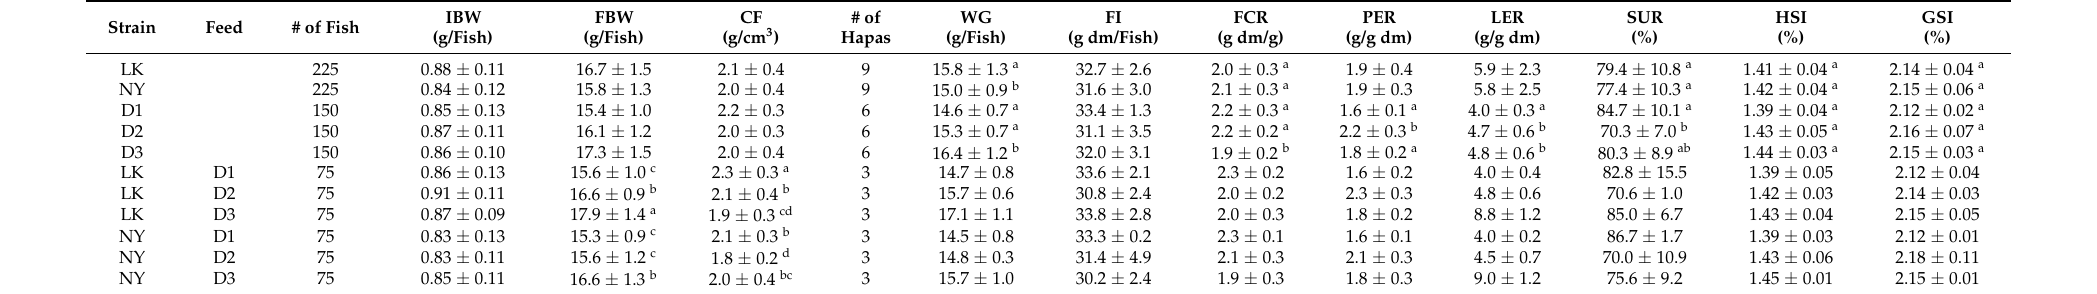
Table 3. Experiment 1 in Bukavu, eastern highlands DR Congo—mean ± standard deviation for initial body weight (IBW), final body weight (FBW), weight gain (WG), feed intake (FI), feed conversion ratio (FCR), protein efficiency ratio (PER), lipid efficiency ratio (LER), survival (SUR), condition factor (CF), hepato-somatic index (HSI), and gonado-somatic index (GSI) of two Nile tilapia strains (LK = the Lake Kivu strain, NY = the Nyakabera strain) fed three feeds (D1 = the fishmeal-based formulated feed, D2 = the fishmeal-freed formulated feed, and D3 = the commercial feed) † .